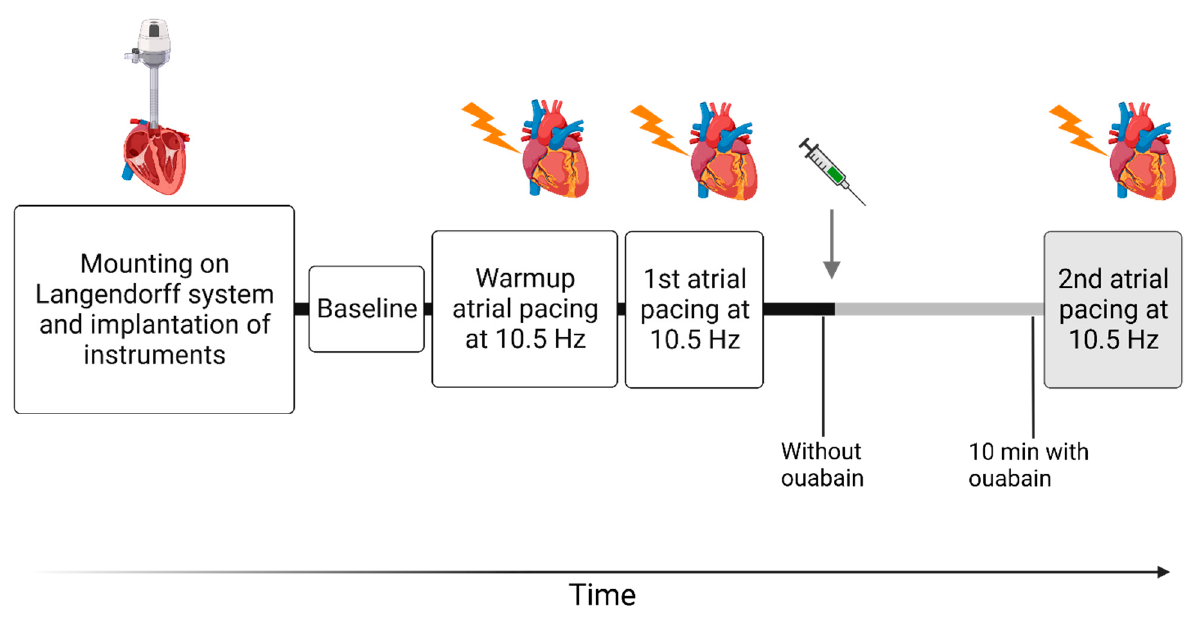
Figure 1. Overview of the protocol assessing the isolated cardiac function. The gray arrow indi- cates the addition of ouabain to the perfusate (1 µM) and the gray bars indicate the subsequent period in the presence of ouabain. First, hearts were excised and mounted in the Langendorff perfusion for functional assessment. Once stabilized, baseline recordings were measured. After the “warm-up” pacing, the protocol contained two sessions of atrial pacing at 10.5 Hz (630 BPM). The first atrial pacing was carried out in the absence of ouabain, and the second pacing session was carried out in the presence of ouabain. These two pacing sessions were carried out in the absence of ouabain in the time-control experiments. In between the first and second atrial pacing sessions, cardiac variables were measured during sinus rhythm in the absence of ouabain and 10 min after ouabain was added to the perfusate. At similar time points, cardiac variables were measured in the time- control experiments, but without ouabain. Figure 1 was created with BioRender.com.